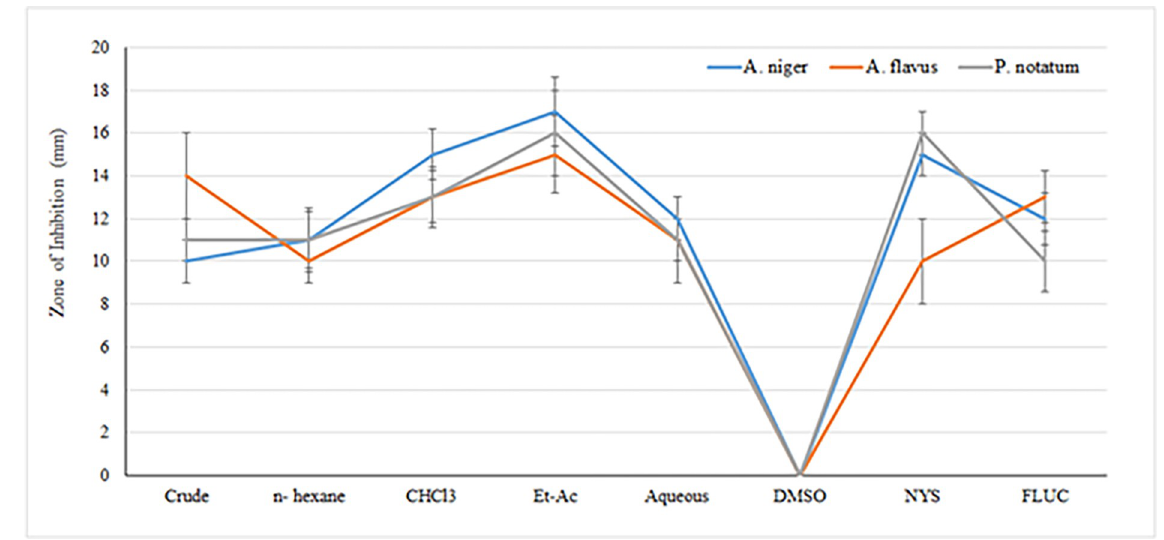
Fig 3. Comparison of antifungal activity of Iris albicans crude extract and its corresponding fractions.